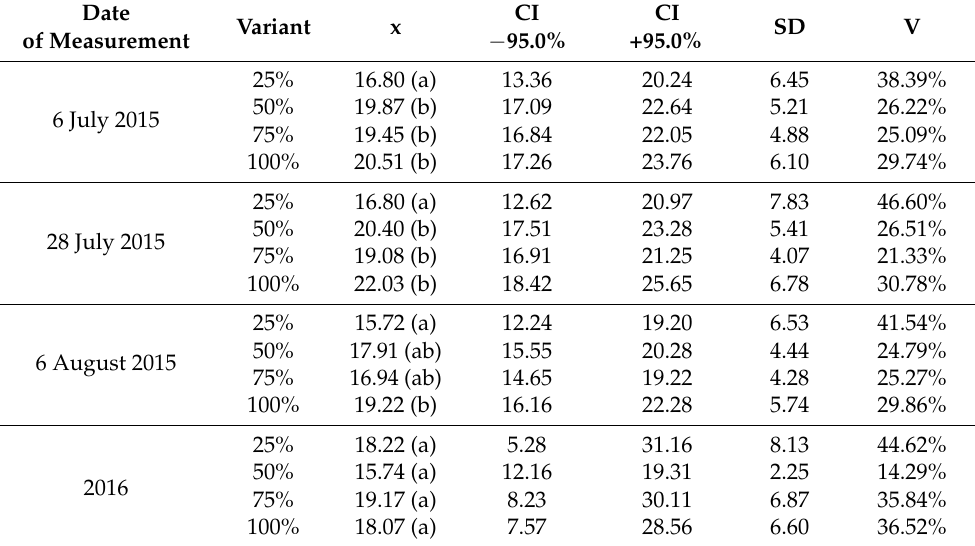
Table 1. Average values of soil moisture by weight (x, confidence intervals (CI), standard deviations (SD) and coefficients of variation (V) for each variants of experiment in 2015 and in 2016. The same letters (a, b) next to the means mean that the means do not differ significantly (Tukey’s test; α = 0.05).